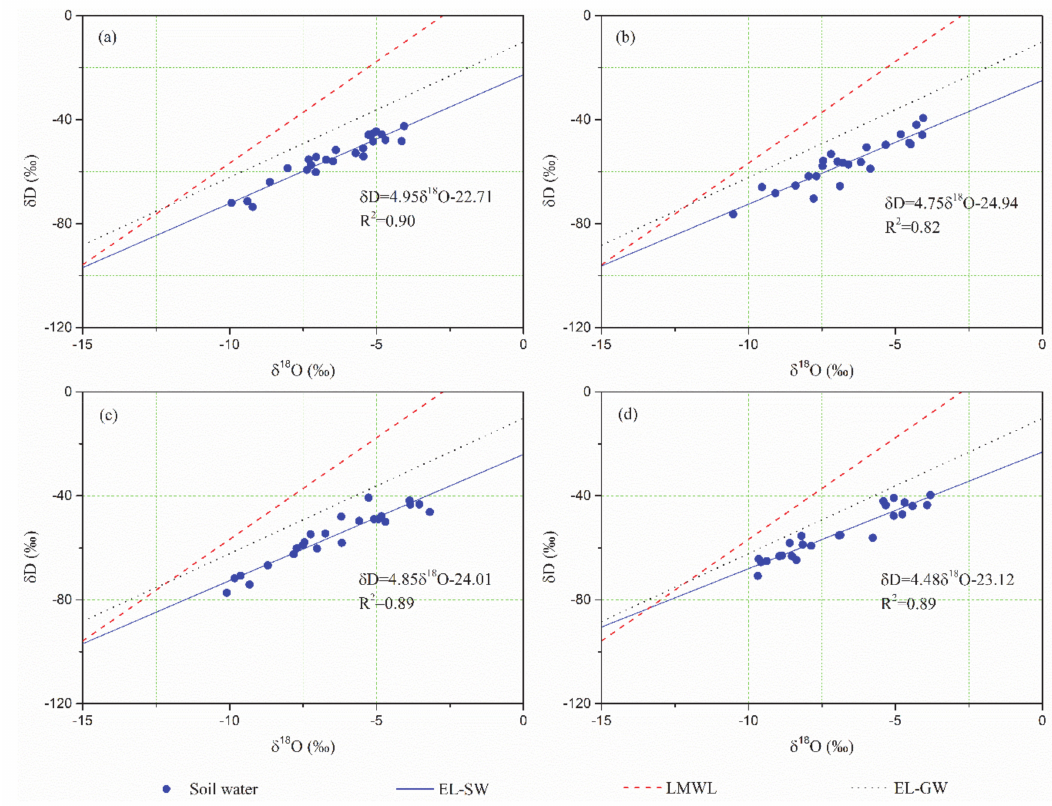
Figure 7. Relationships between δ D and δ 18 O of soil water, groundwater and precipitation under different land use types (( a ) cropland, ( b ) grassland, ( c ) shrubland, ( d )